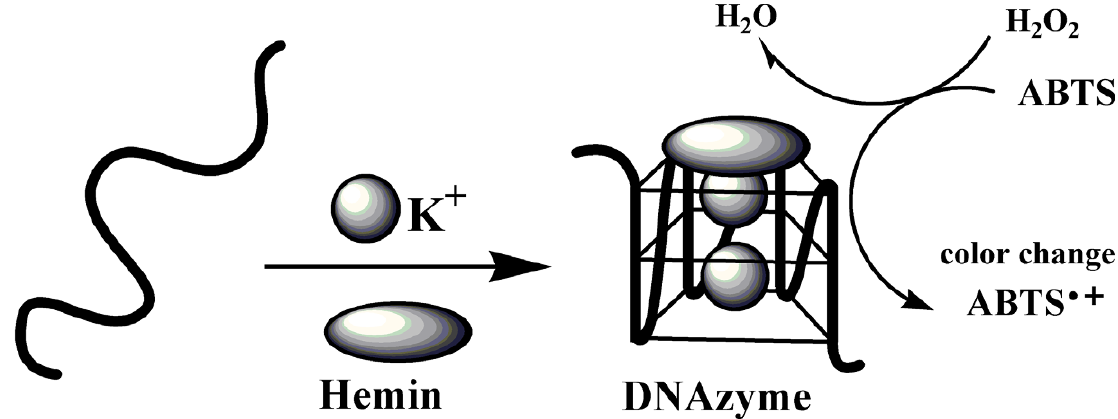
Figure 1. Schematic representation of the DNAzyme based on the G-quadruplex of telomeric repeat sequence and the indicator reaction with